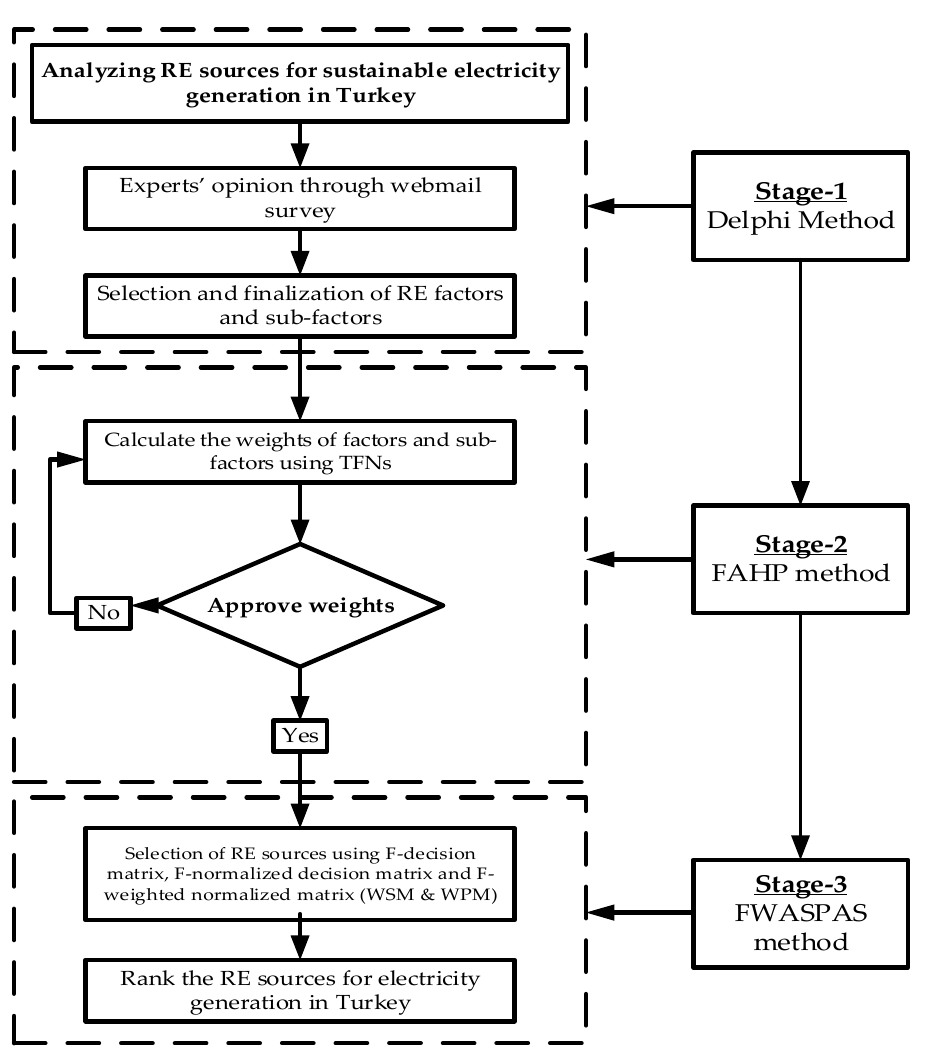
Figure 2. An integrated decision methodology.